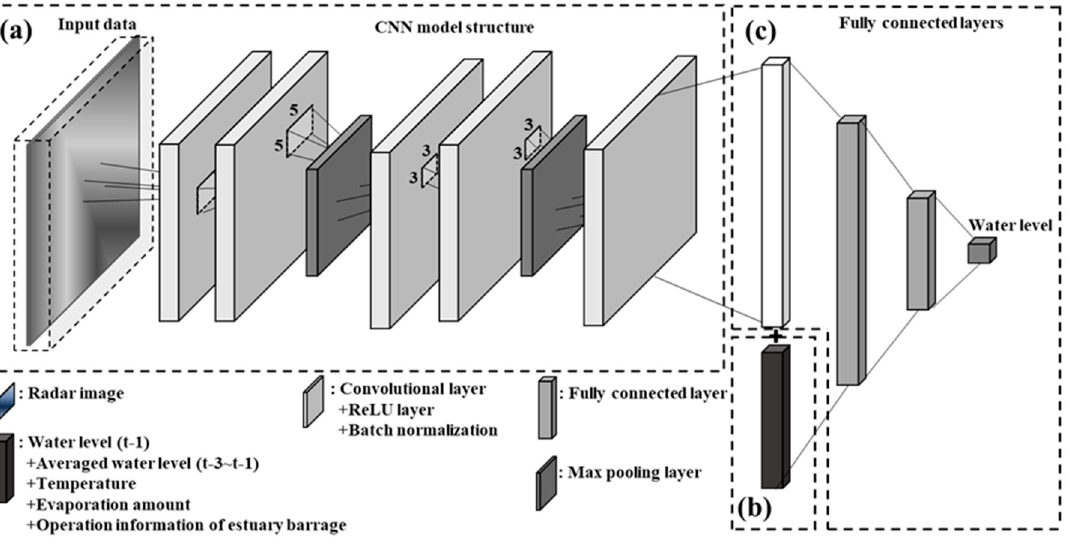
Figure 2. Convolutional neural network (CNN) architectures for simulating the water level: ( a ) convolutional layer for radar images, ( b ) additional information (e.g., water level in the previous day, the averaged water level for the past three days, temperature, operation information of estuary barrage and evaporation), and ( c ) fully connected layer.